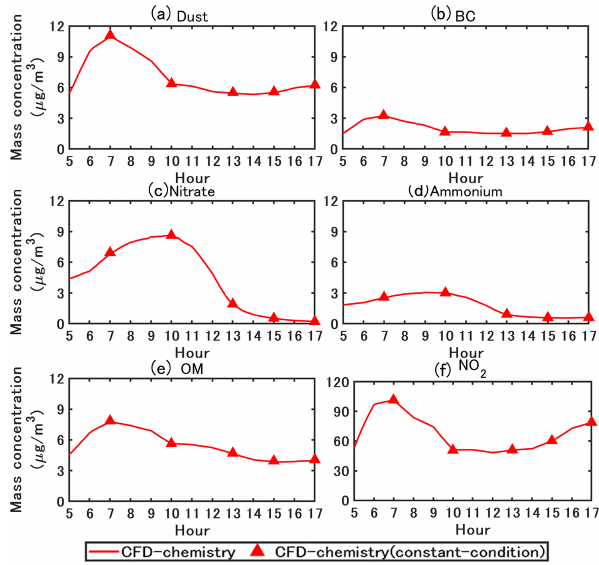
Figure 7. Simulated PM 10 and NO 2 concentrations with the transient-condition and constant-condition methods. The concentra- tions are spatially averaged in the street